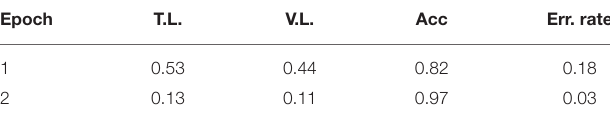
TABLE 8 | Fine-tuning RoBERTa.